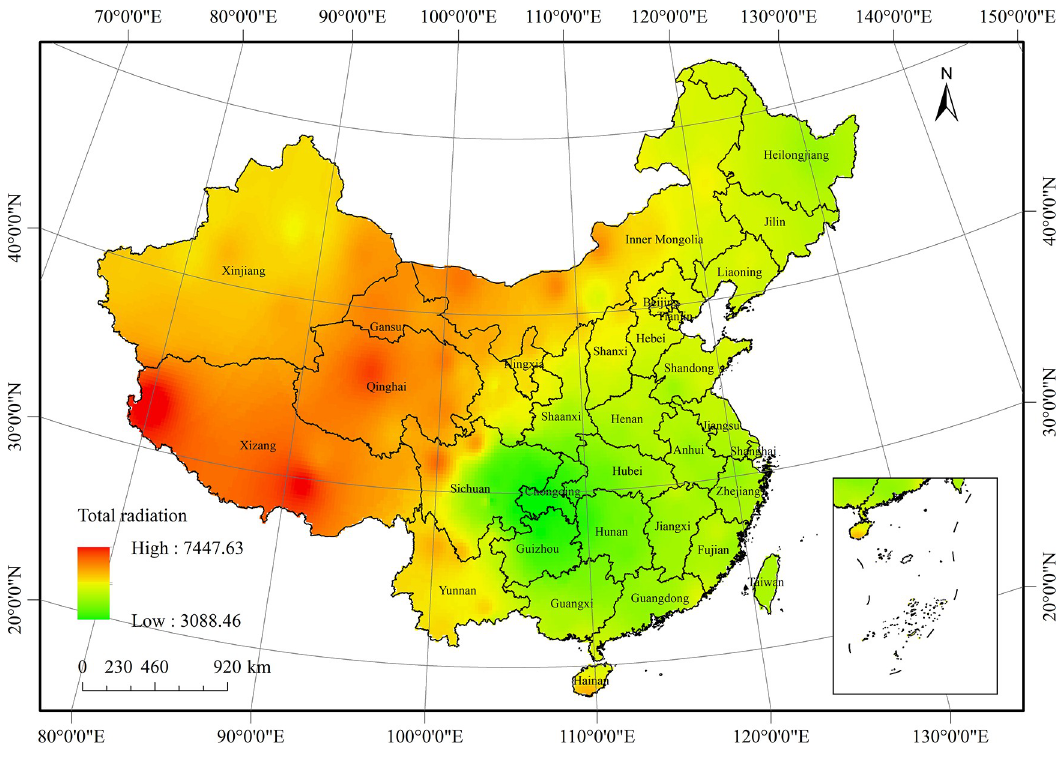
Fig 5. Average distribution of total radiation in China from 1961 to